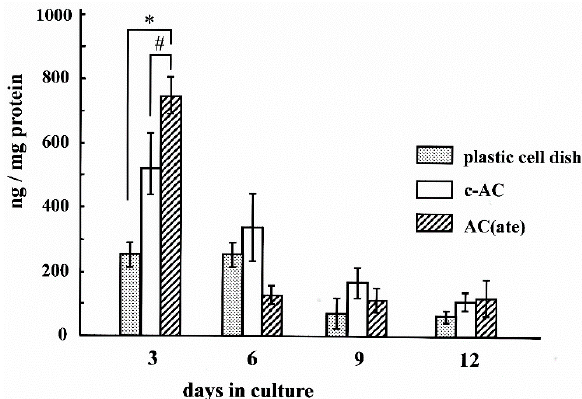
Figure 4. Time course of the amount of procollagen type I carboxy-terminal peptide (PICP) produced by MC3T3-E1 cells in cultures with each type of specimen. Results are shown as the mean ± standard deviation ( n = 5). * and # indicate a significant difference as compared to the plastic cell well and c-AC, respectively (Student’s t -test: p < 0.05).